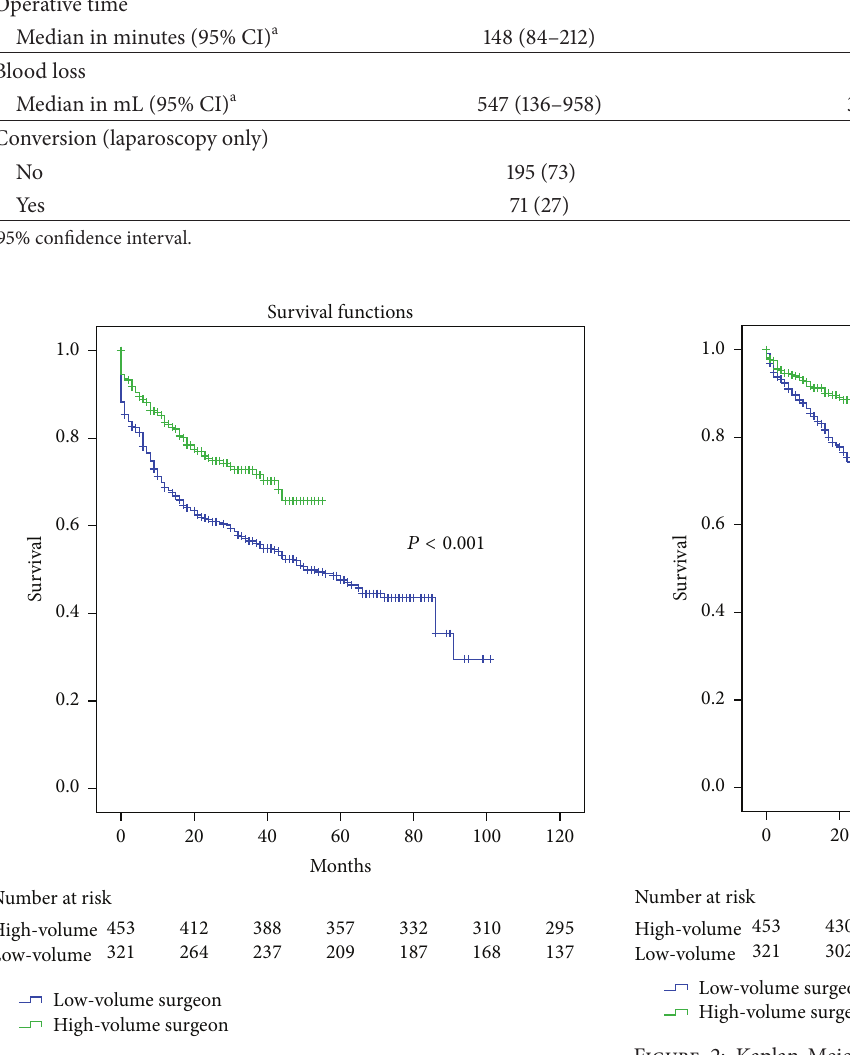
Figure 1: Kaplan-Meier curve for disease-free survival stratified for surgeon volume. Sixty-six percent of the patients operated on by a high-volume surgeon were free of disease after a median follow-up offouryears,comparedto48%ofthoseoperatedonbyalow-volume surgeon ( 𝑃 < 0.001 ).